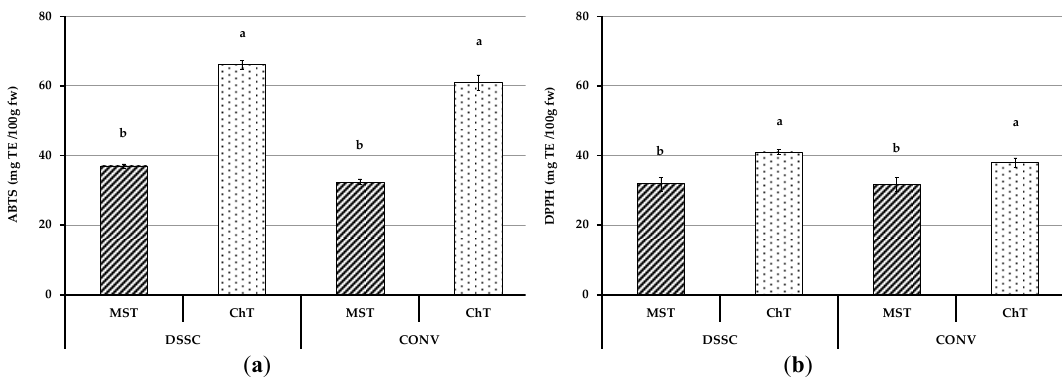
Figure 8. Antioxidant capacity of the fruits of the two tomato hybrids [MST (medium-sized) and ChT (cherry)] in the two greenhouses [DSSC (Dye-Sensitized Solar Cell) and CONV (Conventional)]: ( a ) ABTS (2,2 ′ -azino-bis-3-ethylbenzthiazoline-6-sulphonic acid) assay; and ( b ) DPPH (1,1-diphenyl-2-picrylhydrazyl) assay. Bars with different letters were significantly different by LSD at P ≤ 0.05.